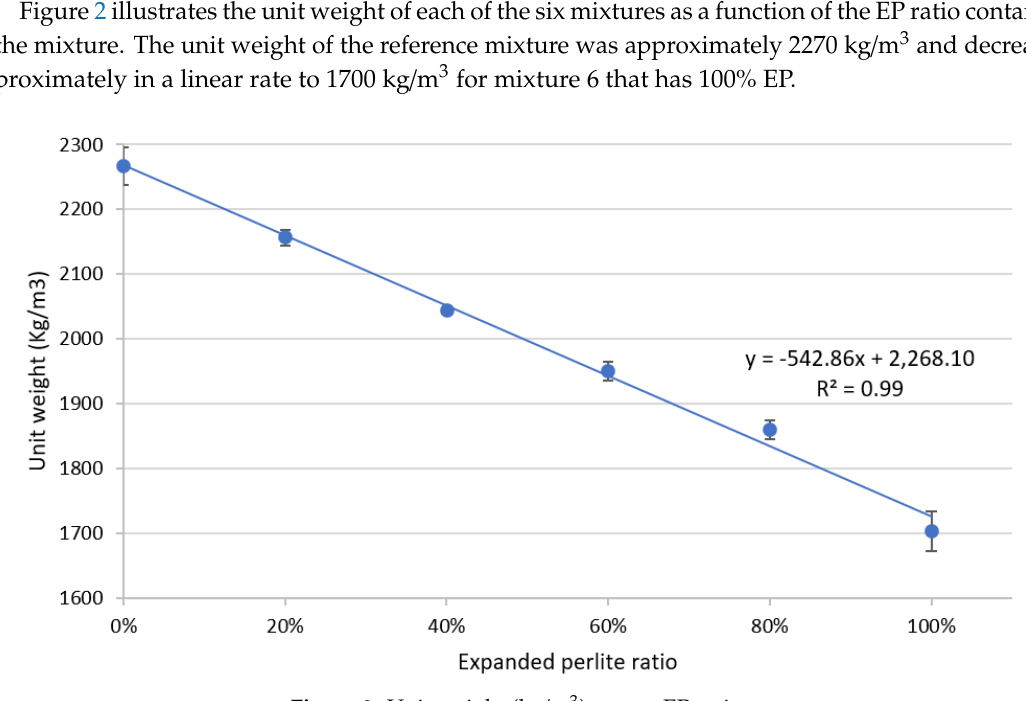
Figure 2. Unit weight (kg/m 3 ) versus EP ratio.